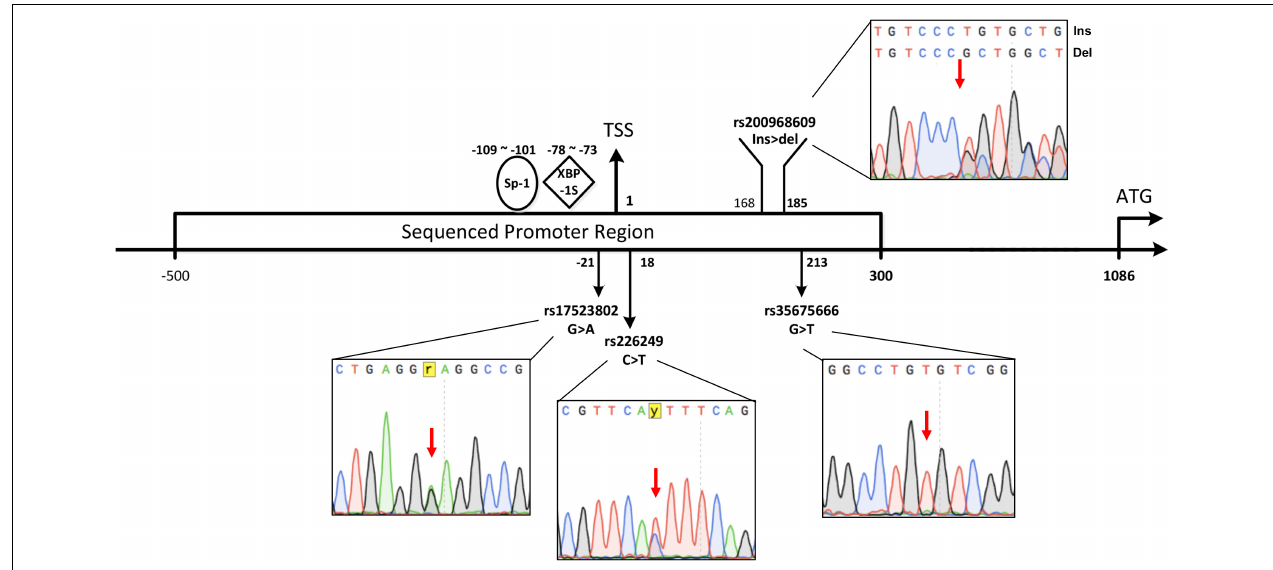
FIGURE 1 | Schematic view of relative positions of the polymorphisms investigated in the study. The first base of TSS was defined as 1, the first upstream base of TSS is –1, the relative positions of 4 polymorphisms observed in our cohort and previous reported functional sites (Sp-1 or XBP-1S binding site) were calculated based on TSS. The range of –500 ∼ +300 across TSS (NC_000001.11: 7961201-7962000) containing the above functional areas of DJ-1 promoter was sequenced in the study. Representative sequence of rs17523802 G > A heterozygote, rs226249 heterozygote, rs200968609 heterozygote, and rs35675666 homozygote were